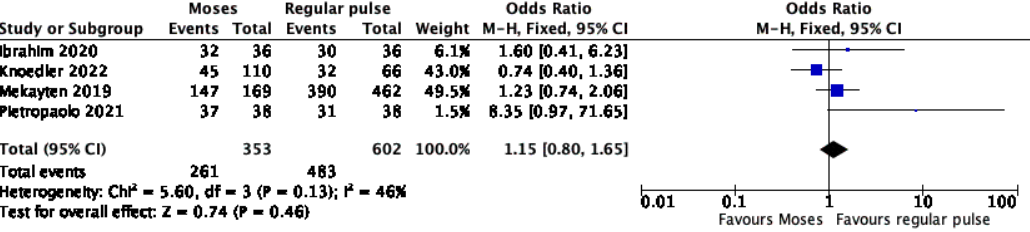
Figure 2. Forest plot of the meta-analysis comparing stone free rate between Moses versus regular pulse modulation [18,35,37,38].